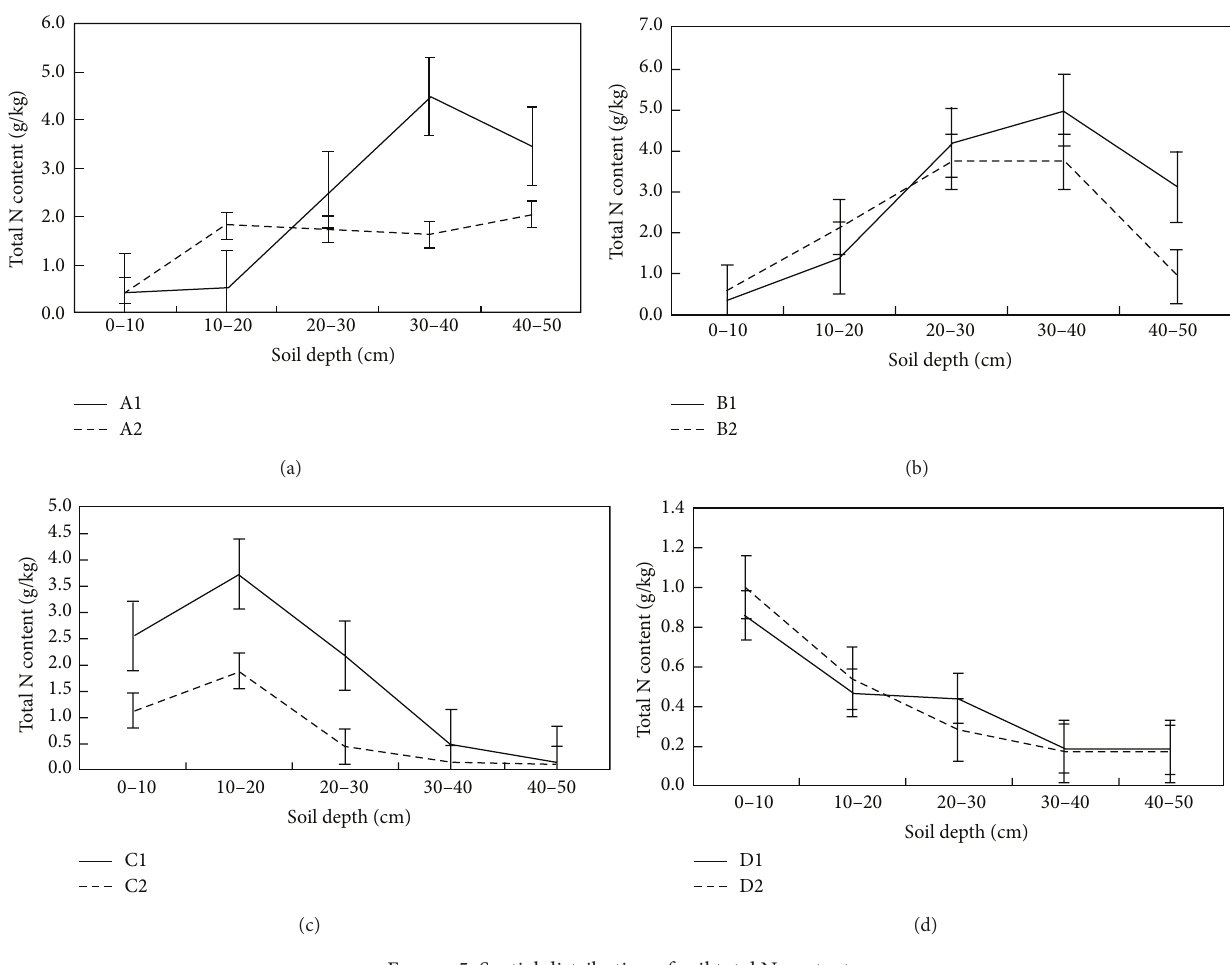
Figure 5: Spatial distribution of soil total N